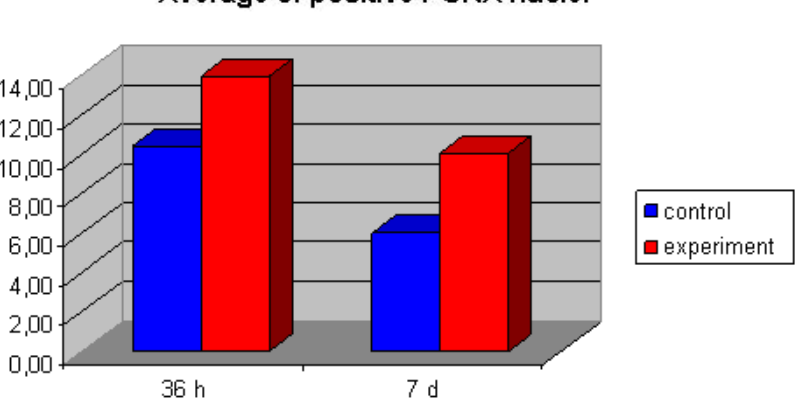
FIGURE 2 – Demonstration of the average of positive PCNA nuclei in the two groups and on both two occasions of